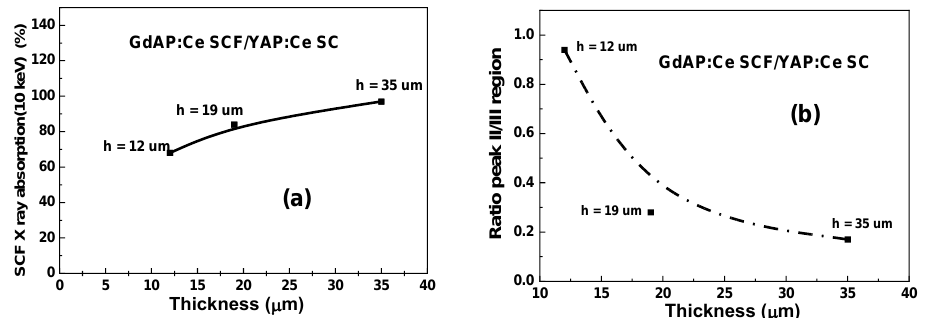
Figure 8. Dependence of X-ray absorption (at energy of 10 keV) on GdAP SCF thickness ( a ) and the ratio between peak TL glow curves from regions II and III in the GdAP:Ce SCF/YAP:Ce SC epitaxial structure ( b ) under excitation by X-rays.